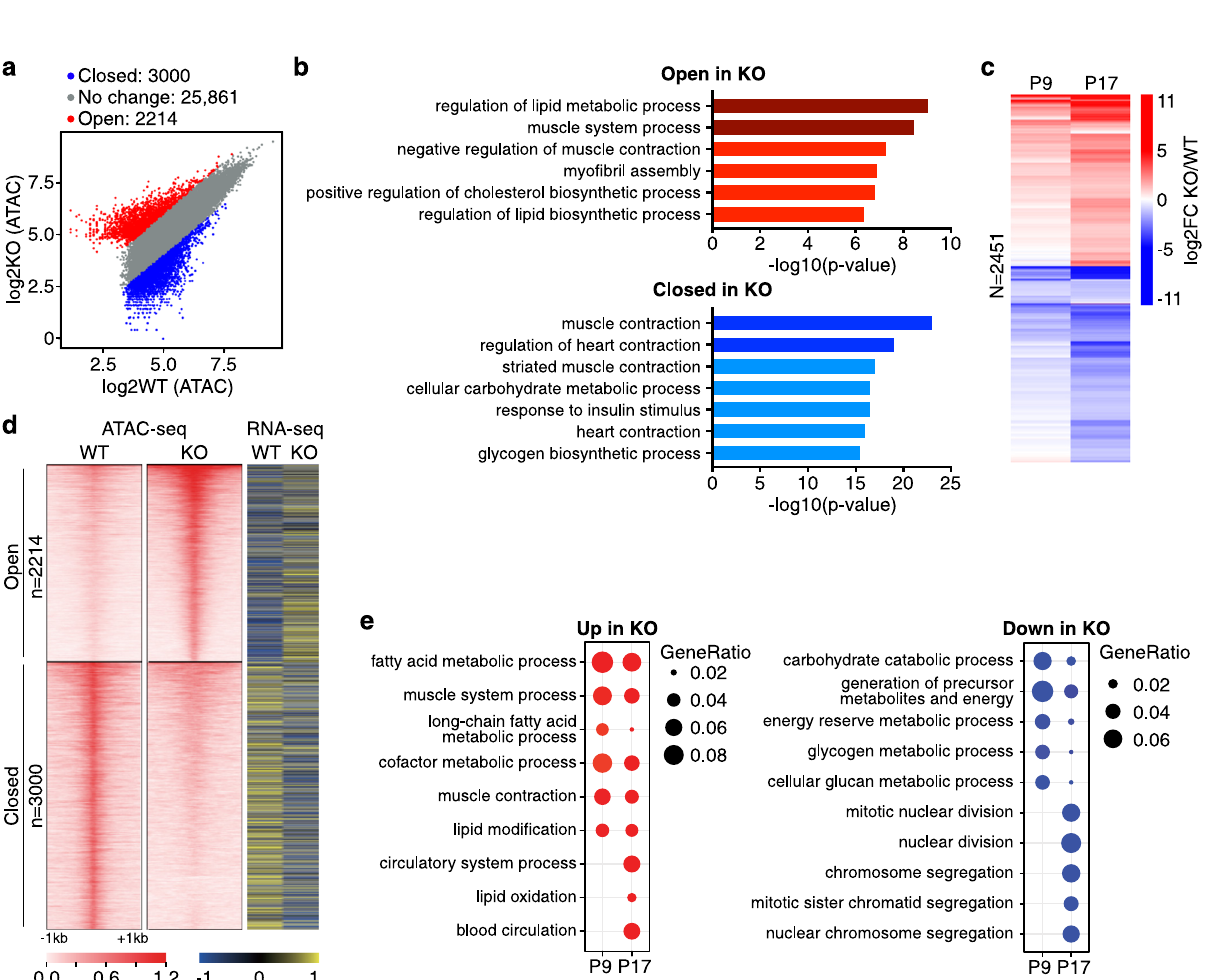
Fig. 2 Net39 maintains integrity of the nuclear envelope. a H&E staining of longitudinal quadriceps sections at P17 (left). Magni fi ed images display the jagged outlines of the indicated nuclei. Arrowheads indicate nuclear envelope protrusions. Scale bars: 20 μ m. Quanti fi cation of the percentage of nuclei with nuclear envelope deformations in the indicated muscles and time points (right). n = 3 WT and KO mice. For each analysis, P9 QD * indicates p = 0.0449, P17 QD p = 0.0037 P17 GPS p = 0.0043. QD quadriceps, GPS gastrocnemius plantaris soleus. b Immuno fl uorescence of the nuclear envelope in longitudinal quadriceps sections at P17 reveals nuclear envelope deformations. Sections were stained for the inner nuclear membrane protein Sun2 (red), phalloidin for F-actin (green), and Hoechst for DNA (blue). Arrowheads indicate nuclear envelope protrusions. Scale bar: 5 μ m. Experiment was performed with two animals per genotype. c Electron micrographs of P17 quadriceps nuclei showing nuclear envelope defects in Net39 KO muscle. Arrowheads indicate nuclear envelope protrusions. Scale bar: 1 μ m. Experiment was performed with three animals per genotype. d Electron micrographs of P17 extensor digitorum longus (EDL) nuclei before and after ex vivo stretching (left) and quanti fi cation of the percentage of nuclei with nuclear envelope deformations (right). Arrowheads indicate nuclear envelope protrusions. Scale bar: 1 μ m. p = 0.3. n = 3 WT and KO mice. Data are presented as mean ± SEM values. e Western blot analysis showing protein levels of LMNB1, LMNA, LEMD2, EMD, and SUN2 in P17 quadriceps muscle lysates from WT and Net39 KO mice. Vinculin (VCL) and Histone H3 are loading controls for total protein and nuclear protein, respectively. f Densitometry quanti fi cation of western blot from Fig. 2e. The intensity of each nuclear envelope protein was normalized to Histone H3 intensity. n = 2 biological replicates. g Net39 BioID in C2C12 myotubes detects enrichment of biotinylated LEMD2, SUN2, and EMD but not Lamin A in C2C12 myotubes. GAPDH is a loading control. Total biotinylated proteins were detected using streptavidin-HRP (STV). Two independent experiments were performed. h Validation of Net39 interaction with Lemd2 by co- immunoprecipitation in C2C12 myotubes. VCL is a loading control. Two independent experiments were performed. All statistical comparisons between